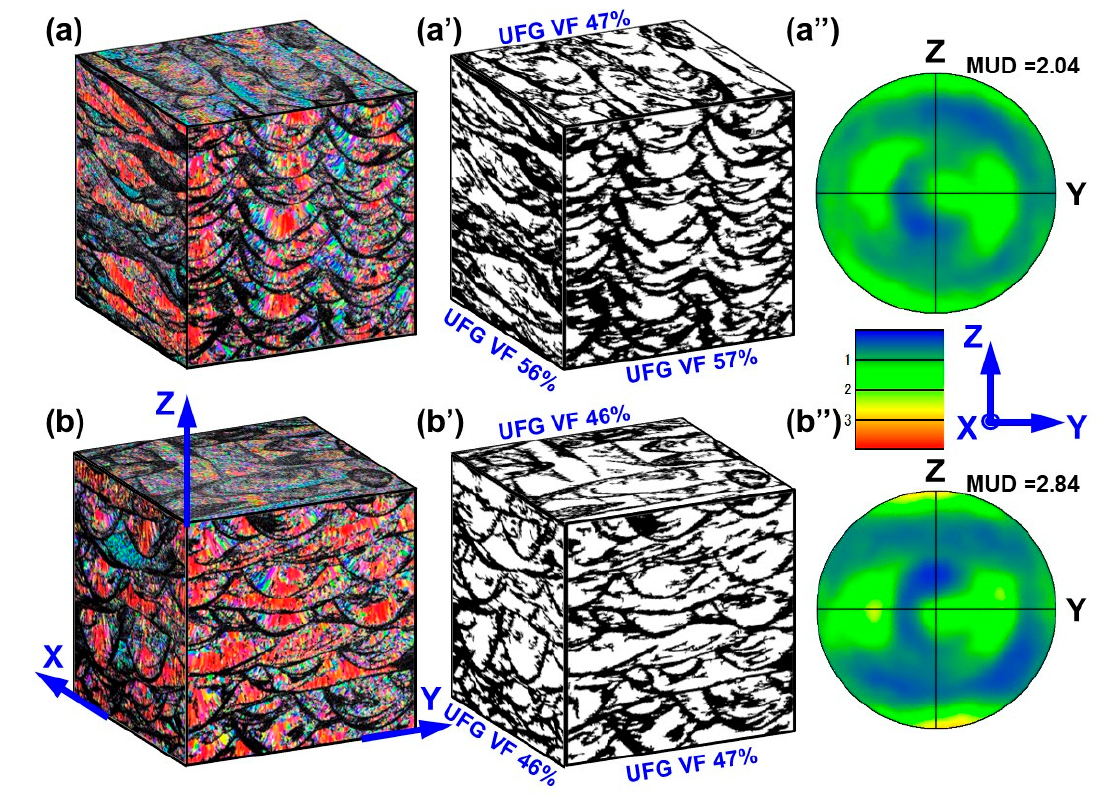
Figure 4. Three-dimensional ( a , b ) EBSD grain orientation maps and ( a’ , b’ ) extracted UFG regions with the VF of UFGs in all three planes; ( a’’ , b’’ ) the pole figures of the YZ plane of the X- and XY-scan samples.